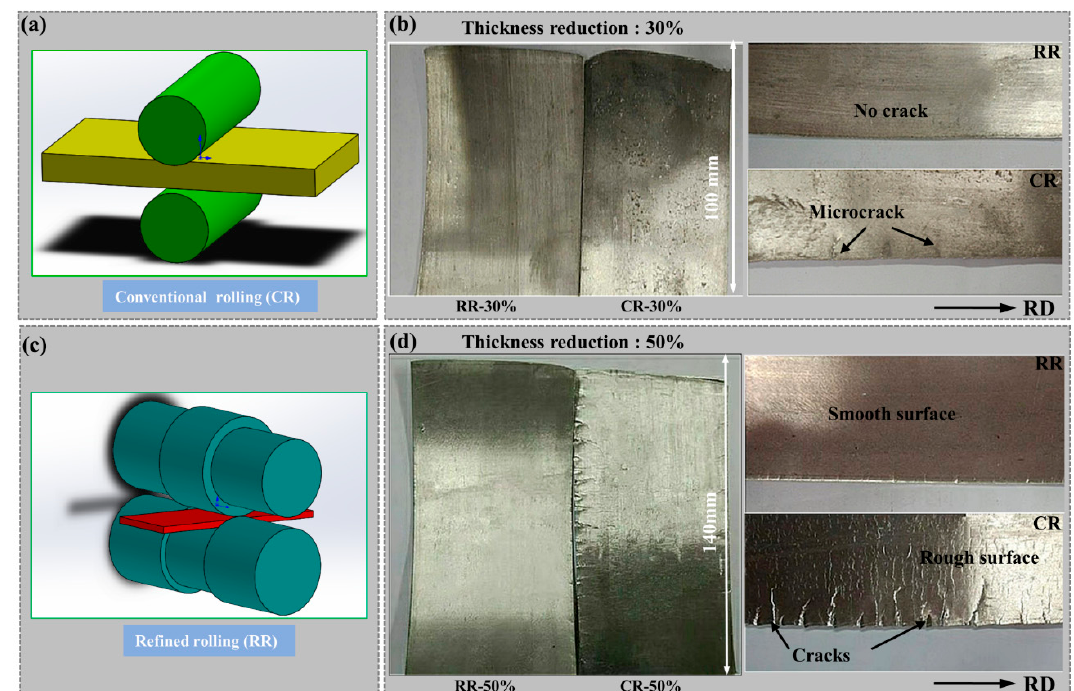
Figure 1. ( a , c ) Schematic diagram of the rollers and ( b , d ) crack behavior.